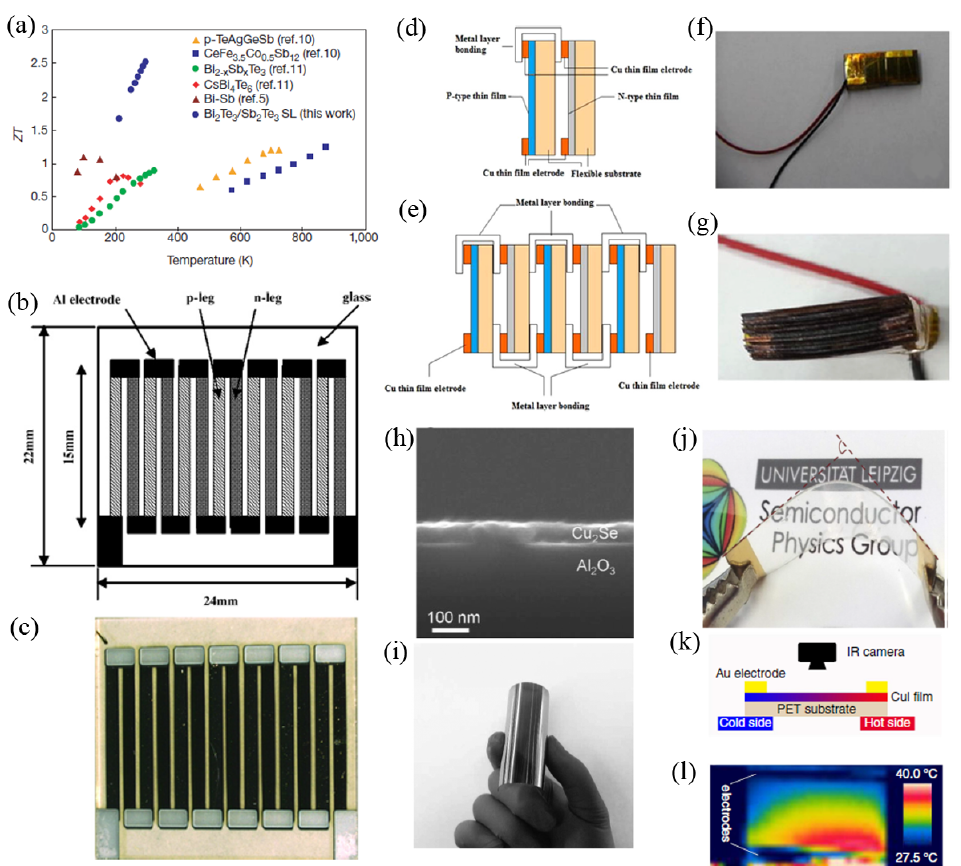
Figure 1. ( a ) Temperature dependence of figure of merit (ZT) of 10 Å/50 Å p -type Bi 2 Te 3 /Sb 2 Te 3 superlattice compared to those of several recently reported materials. Reproduced from [31] with permission; Copyright Nature Publishing Group 2001; Schematic illustration ( b ) and photograph ( c ) of the bismuth-telluride-based alloy thin film thermoelectric (TE) generator. Reproduced [32] with permission; Copyright Elsevier 2007; Schematic illustration of the Zn based thin film TE generator (TFTEG): ( d ) A p - n couple was formed through connecting the n -type Al-doped ZnO and p -type Zn-Sb based thin films by metal layer bonding with Cu films deposited on both sides of the substrate; ( e ) Structure of the whole TFTEG; ( f ) and ( g ) are pictures of real Zn based TFTEG products. Reproduced [35] with permission; Copyright AIP Publishing 2015; ( h ) Cross-section scanning electron microscopic (SEM) image of the Cu 2 Se thin film on Al 2 O 3 substrate; ( i ) Photograph of the Cu 2 Se thin film on the polyimide substrate. Reproduced [27] with permission; Copyright John Wiley & Sons, Inc. 2017; ( j ) The photograph of a CuI thin film sample deposited on polyethylene terephthalate (PET) substrate with a bending angle; ( k ) Schematic illustration for the power output measurement of the CuI/PET single-leg TE device; and, ( l ) The example infrared image taken during one of the measurements. Reproduced from [28] with permission; Copyright Nature Publishing Group 2017.